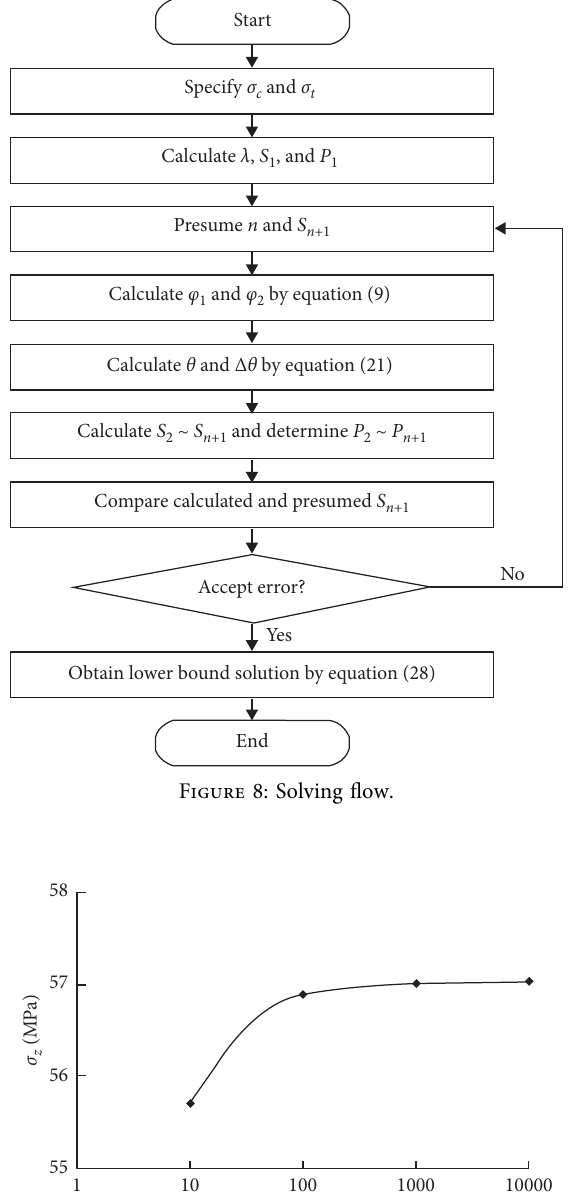
Figure 9: Correlation between bearing capacity and stress column amount.